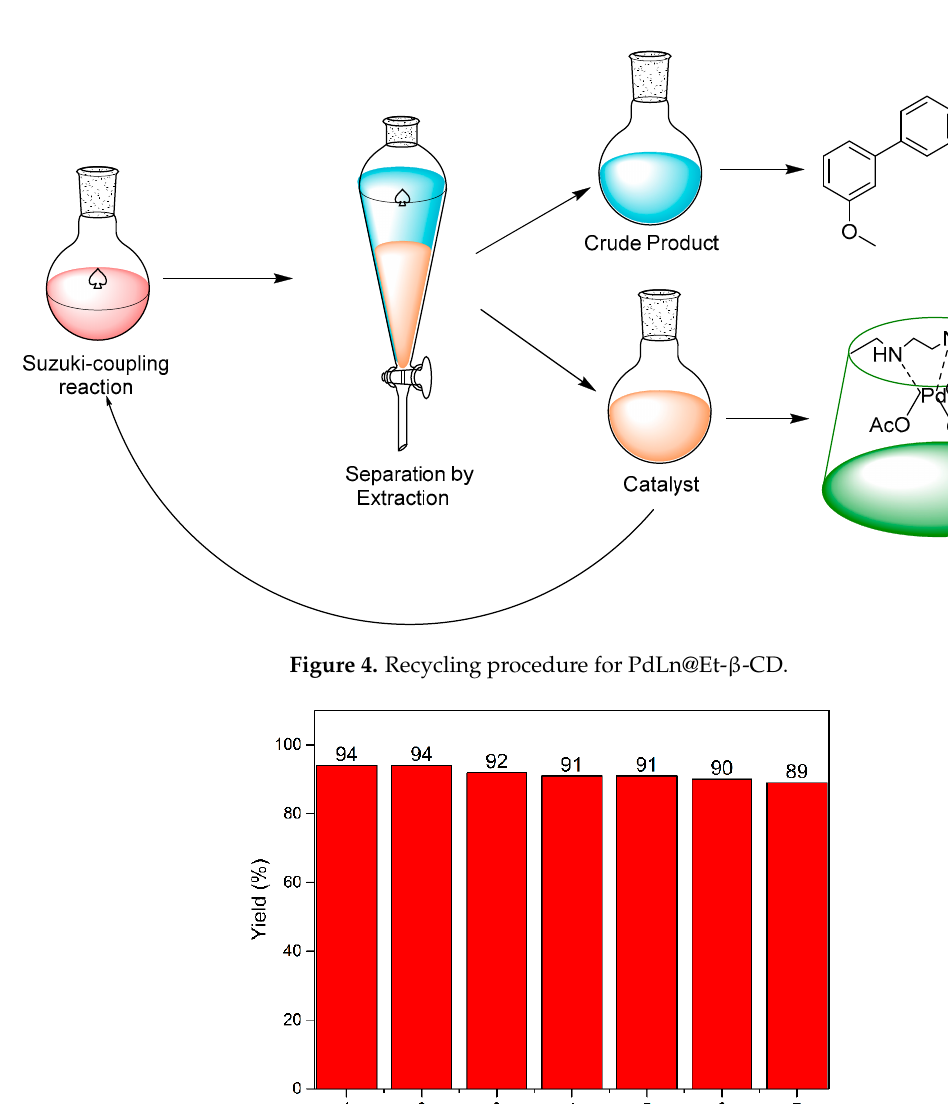
Figure 5 . Recycling of PdLn@Et ‐β‐ CD. Figure 5. Recycling of PdLn@Et-